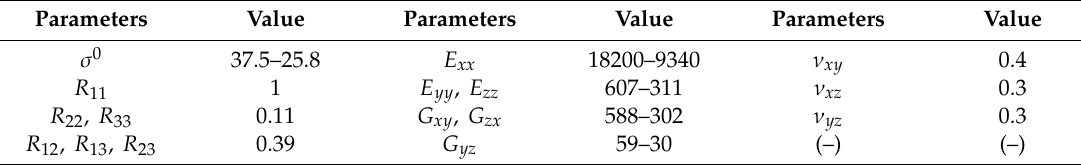
Table 4. Summary of the timber parameters of the FEM